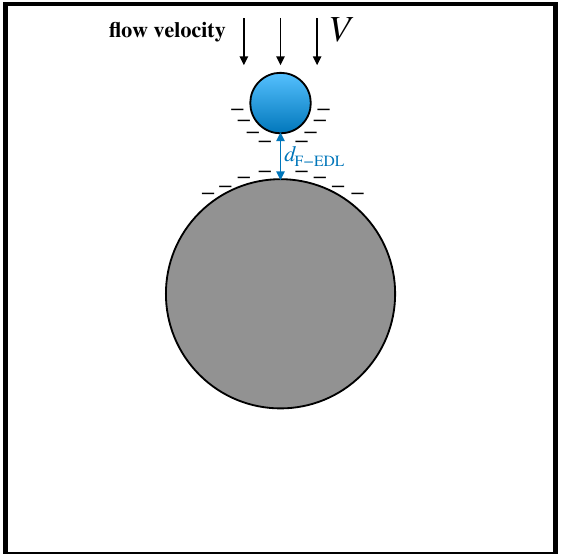
Figure 6. Schematic representation of the electrostatic displacement resulting from the equilibrium between electrostatic repulsive interactions and viscous drag acted upon the particle by the suspending